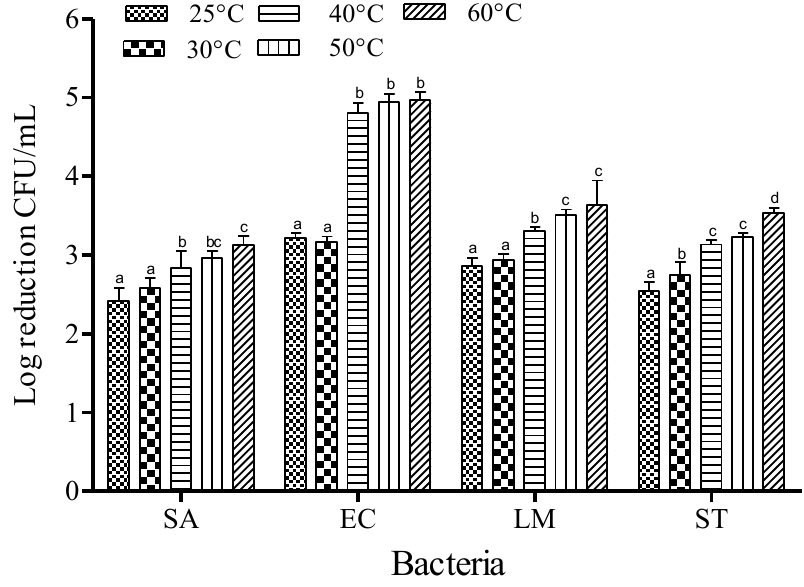
Figure 2. Inactivation of different foodborne pathogens treated with slightly acidic electrolyzed water (5 ppm and 1 min) at different temperatures. Vertical bars represent means of three replications ± standard deviation. Bars labeled with different letters indicate significant differences at p < 0.05. SA: S. aureus , EC: E. coli O157:H7, LM: L. monocytogenes , ST: S. Typhimurium. The initial level of each foodborne pathogen was 8.86, 7.68, 7.43, and 8.56 for EC, SA, LM, and ST,